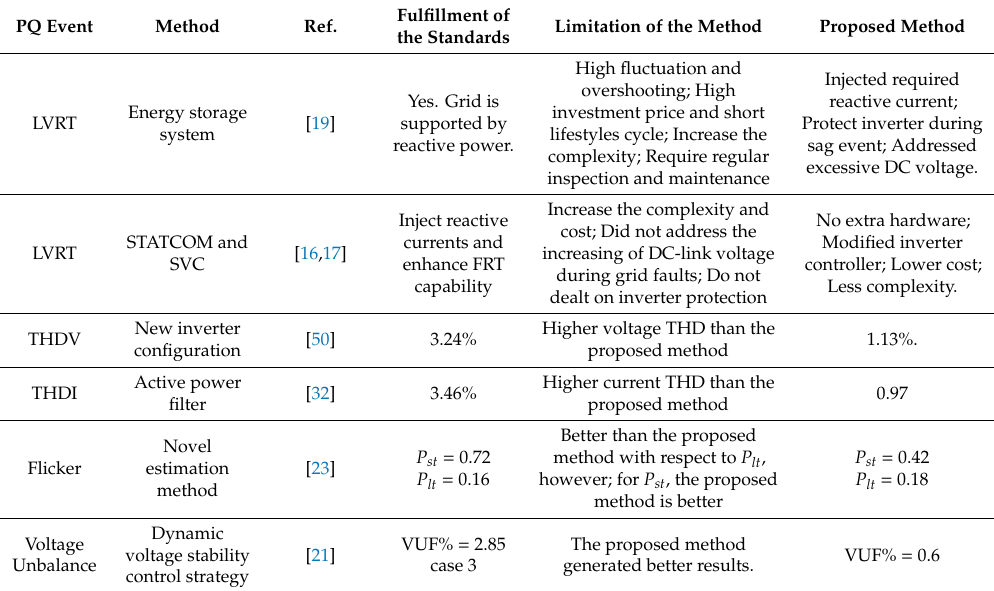
Table 5. Comparison table between the proposed and existing